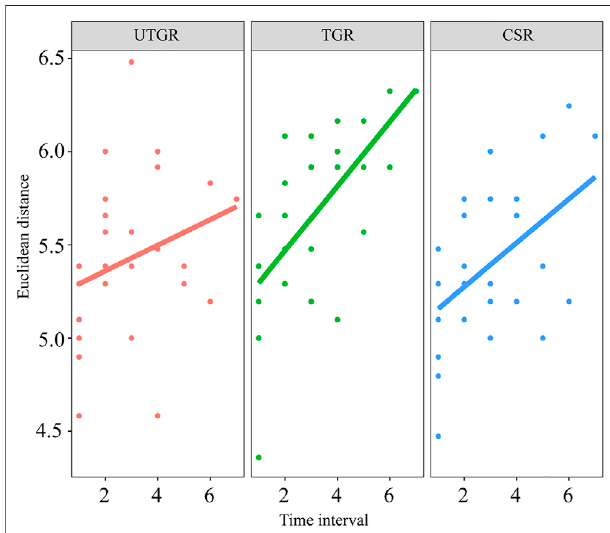
FIGURE 6 | Directional changes in the composition of fi sh communities in different habitat types in the upper reaches of the Yangtze River.